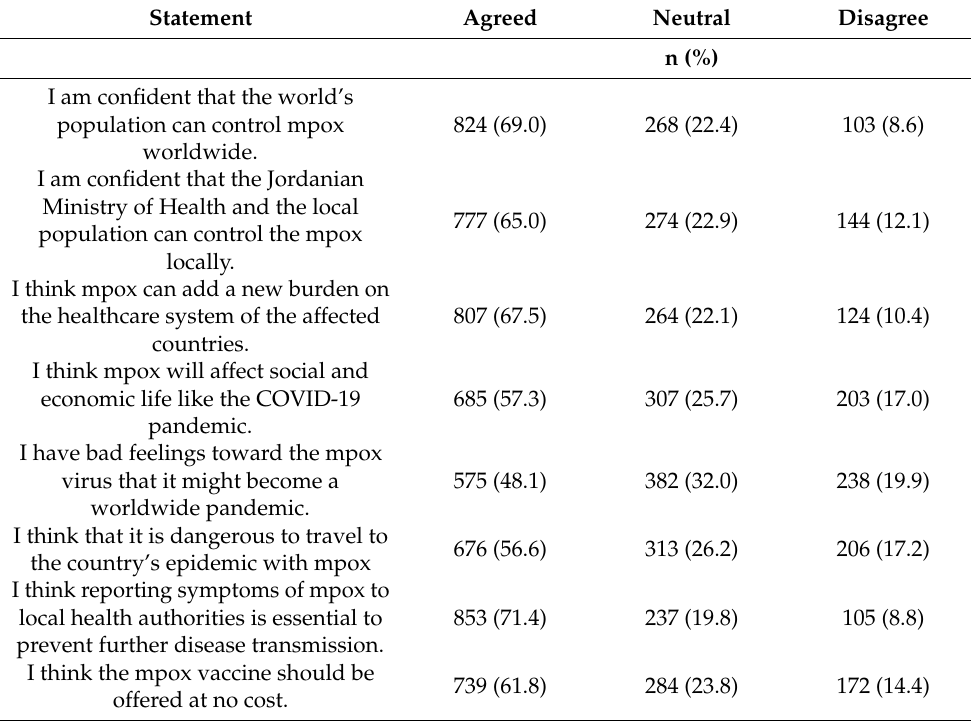
Table 4. Perception about human mpox (n = 1195).